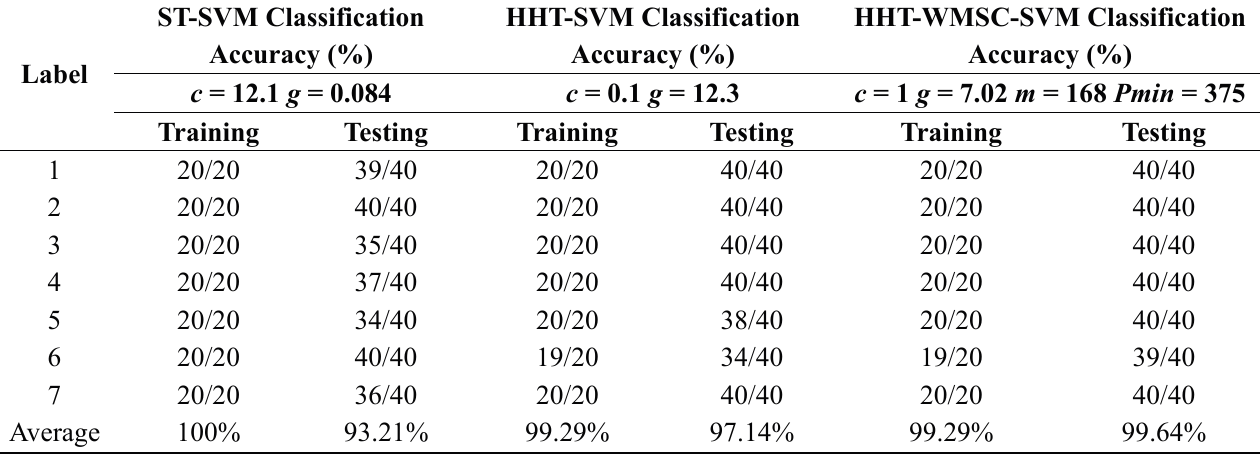
Table 5. Bearing fault detection results obtained by the ST-SVM, HHT-SVM and HHT-WMSC-SVM models for dataset B.